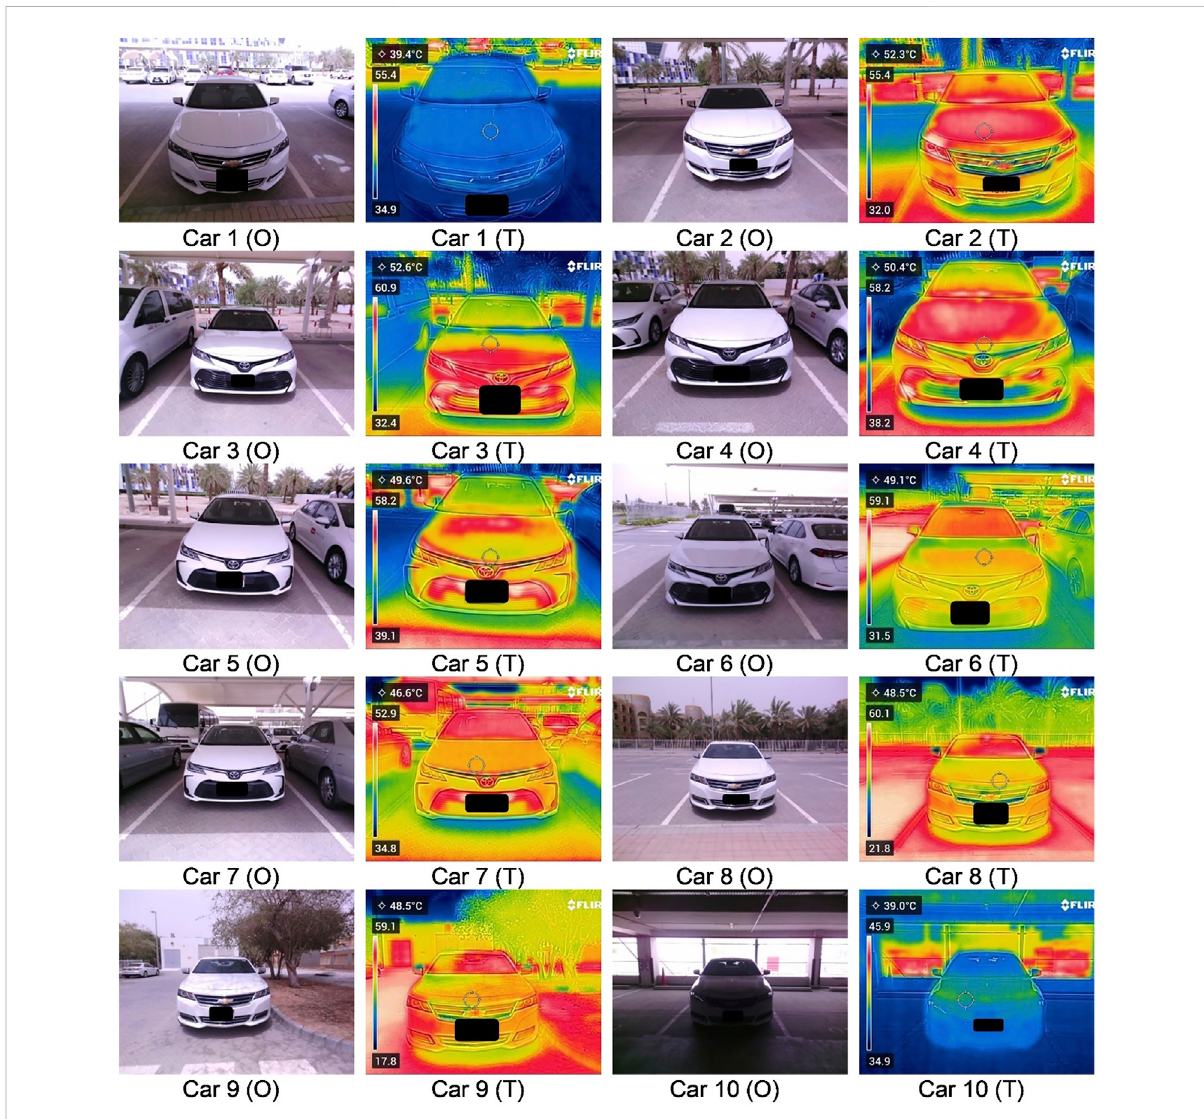
FIGURE 1 Optical and thermal images of cars parked under various shading